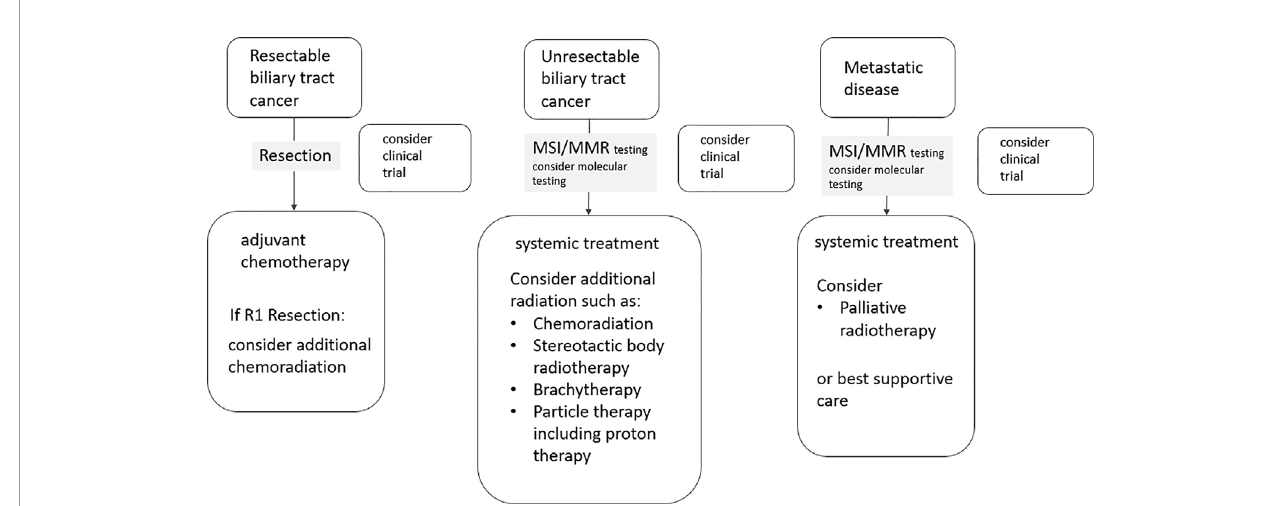
FIGURE 2 | Flow chart illustrating the integration of radiotherapy in the treatment of biliary tract